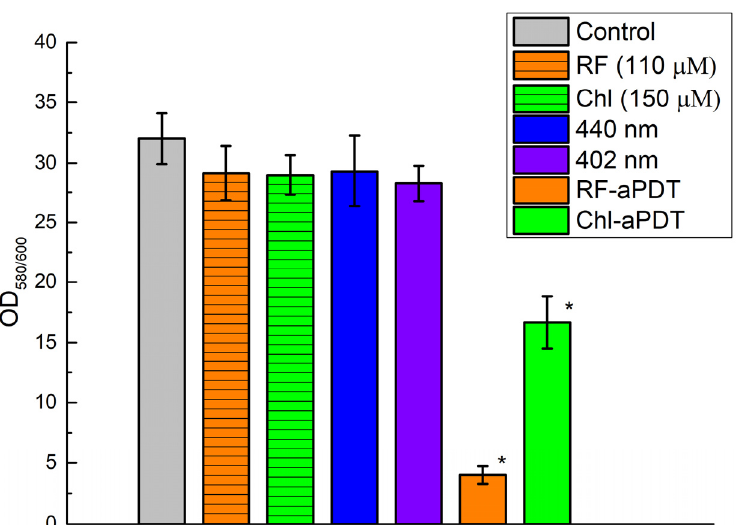
Figure 6. Effect of aPDT on the destruction of A. baumannii biofilms as quantified by crystal violet (CV) assay. Samples: Control—without PS and non-irradiated; 440 nm and 402 nm—irradiated without PS; RF-aPDT—with 110 µ M RF and irradiated with 440 nm; Chl-aPDT—with 150 µ M Chl and irradiated with 402 nm. Every point is the average of OD 580/600 ratio of three independent experiments, error bars indicate standard deviation, * indicates statistical significance compared to control culture, p <